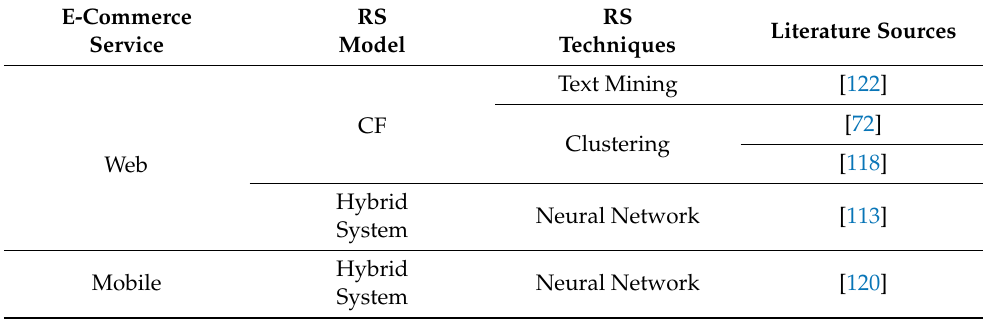
Figure 19. Product recommendation system that extends item-based CF through online–offline data combination. Table 8. E-commerce service field recommendation system study.